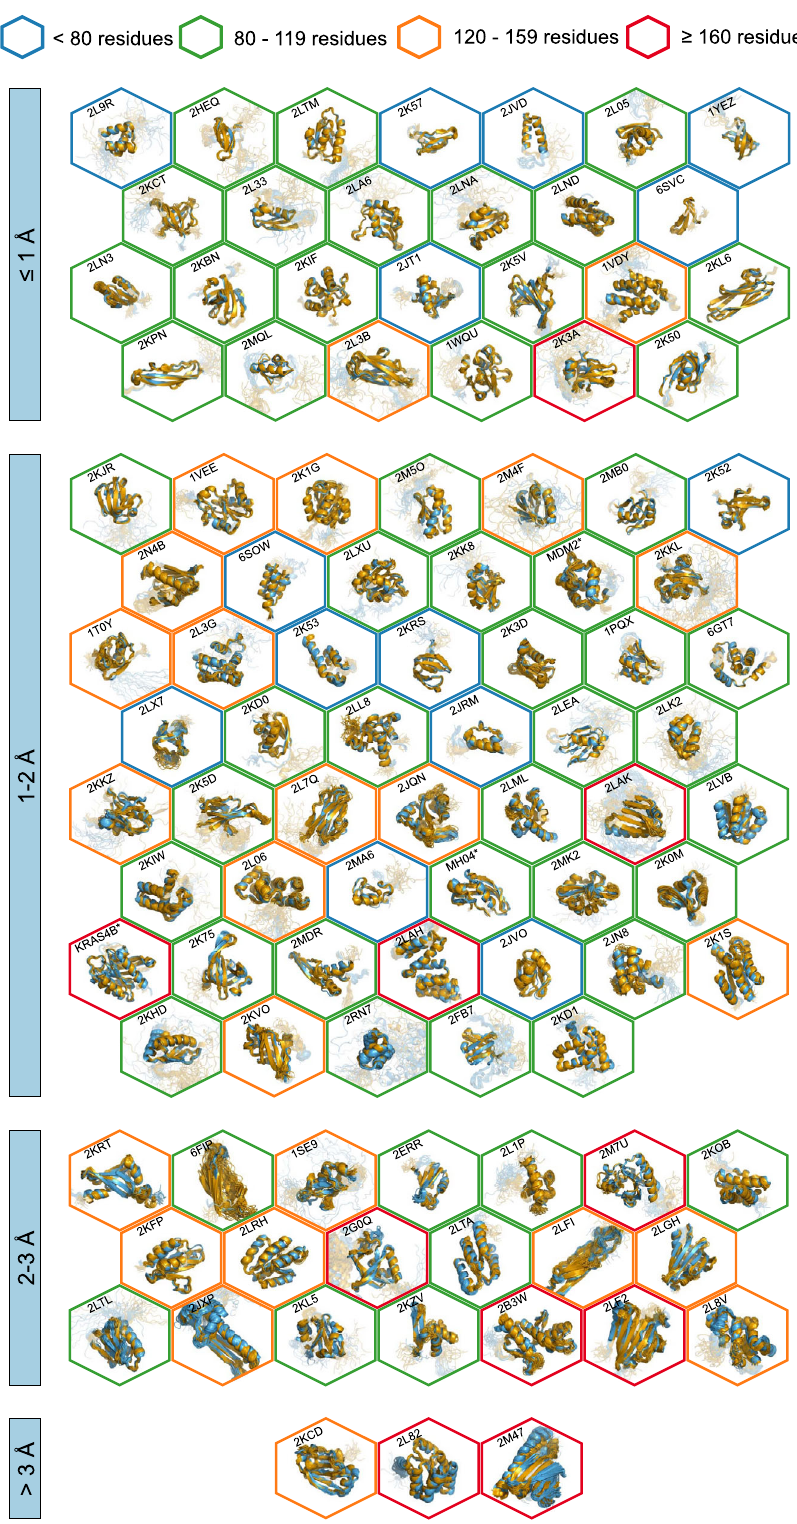
Fig. 3 | 100 protein structures determined automatically by ARTINA (blue) overlaid with corresponding PDB depositions (orange). The structures are aligned with the RMSD to reference range as indicated on the left and hexagonal